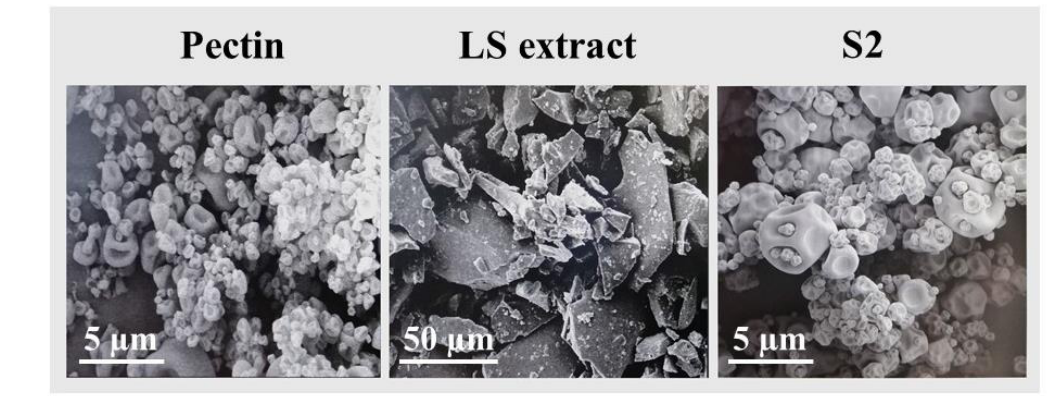
Fig. 7: SEM micrographs of pectin (3000 × ), LS extract (500 × ), and S2 (3000 × )